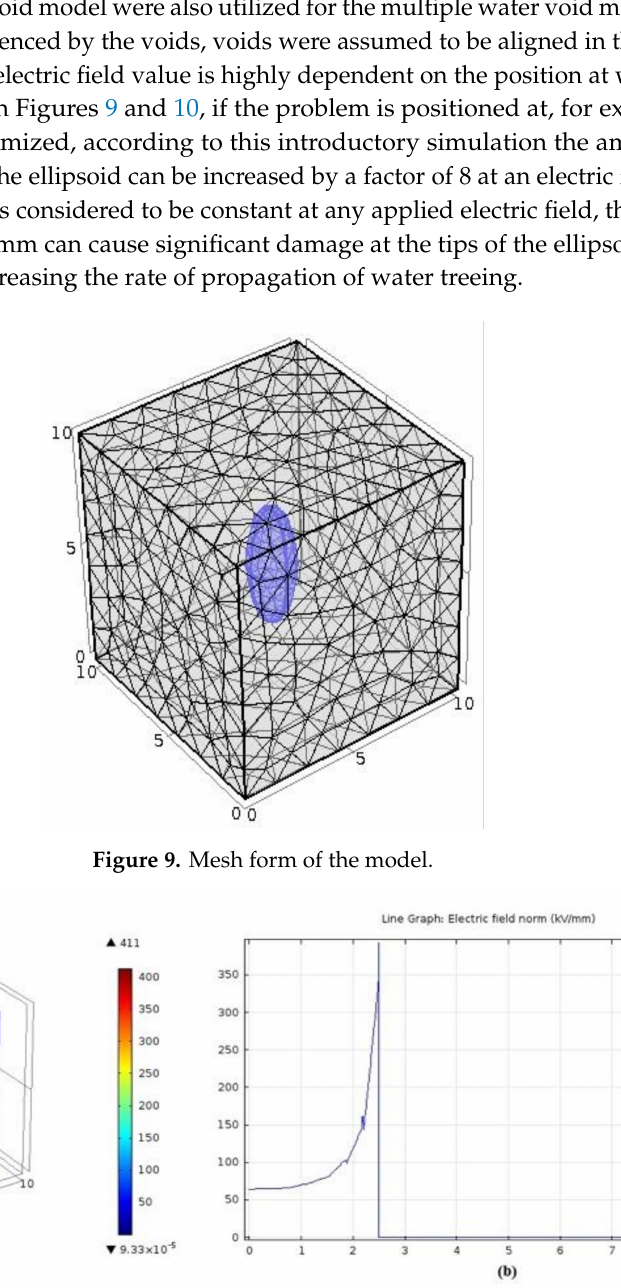
Figure 10. Electric field norm: ( a ) slice view of electric field norm distribution; ( b ) electric field norm enhanced at the tips of an ellipsoid in the middle of the